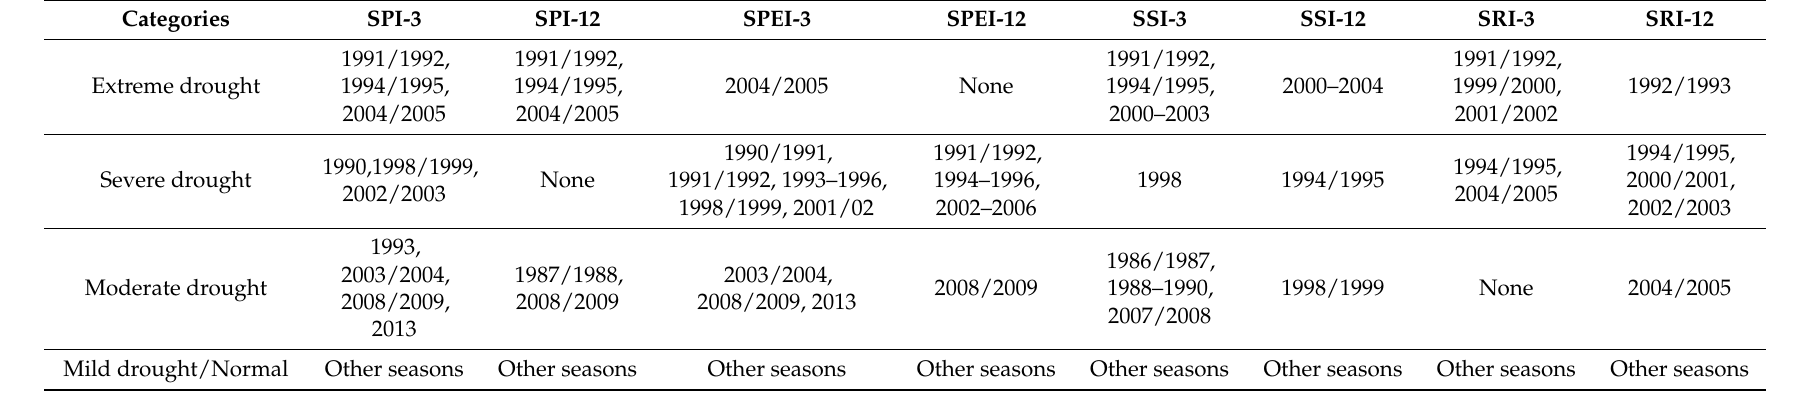
Table 4. Categories of droughts captured by different